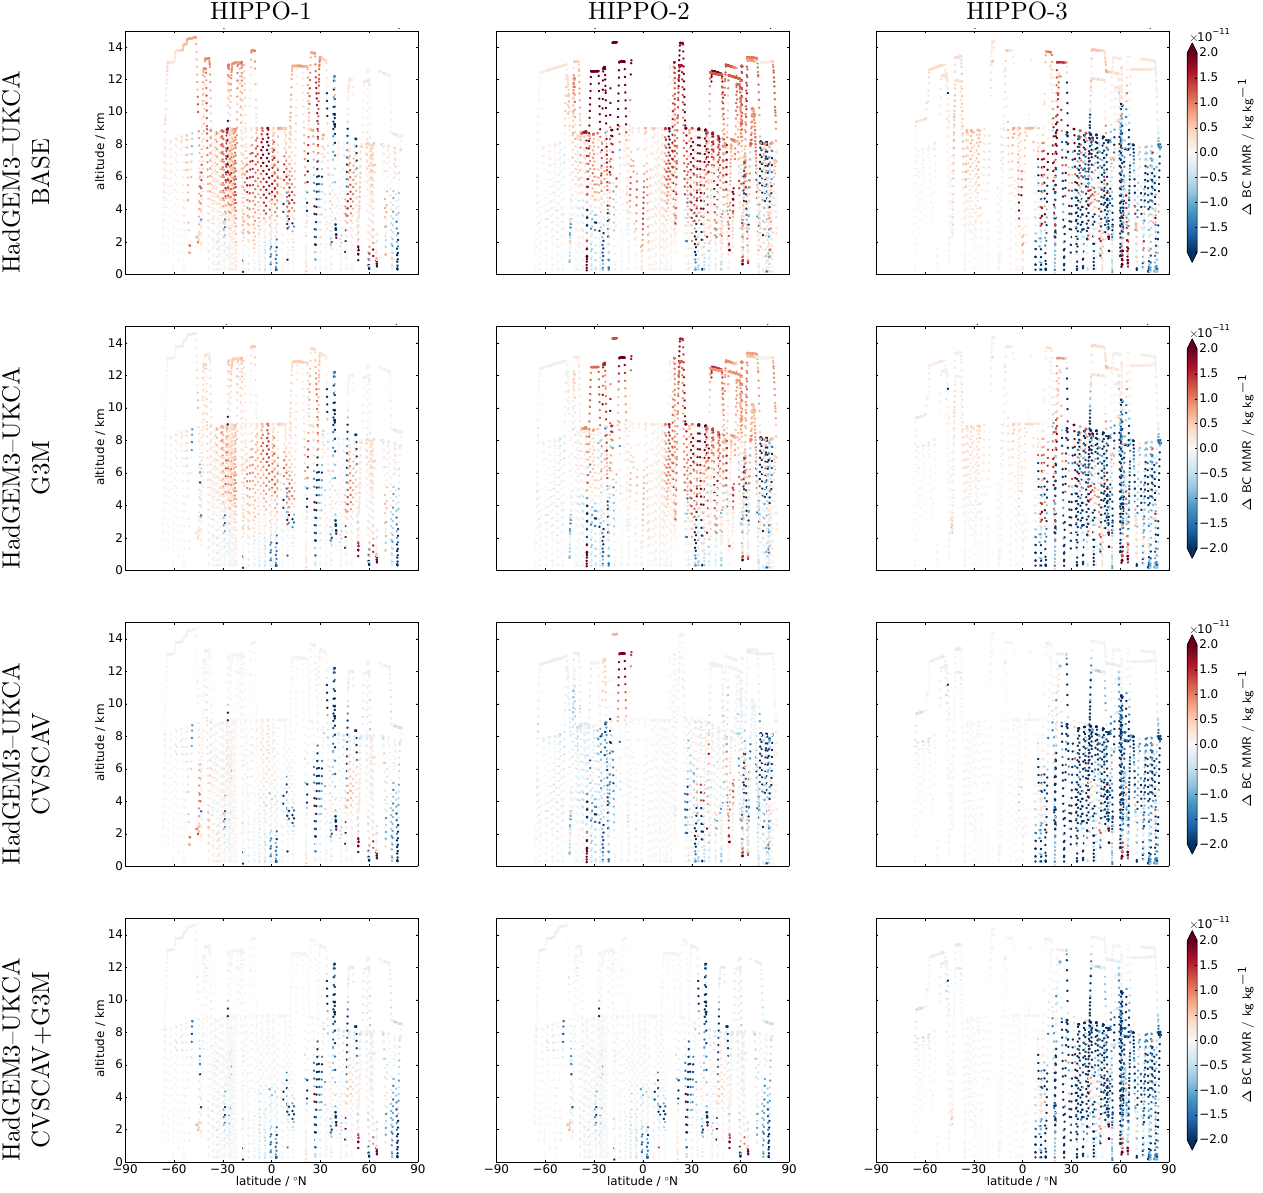
Fig. 3. Difference of BC mass mixing ratio (kgkg − 1 ) simulated by HadGEM3–UKCA in each configuration (rows) from that observed during each phase of the HIPPO campaign (columns). The model is nudged and sampled along the HIPPO flight track at 1-min intervals; observed mixing ratio is calculated from HIPPO SP2 data aggregated over 1-min intervals.